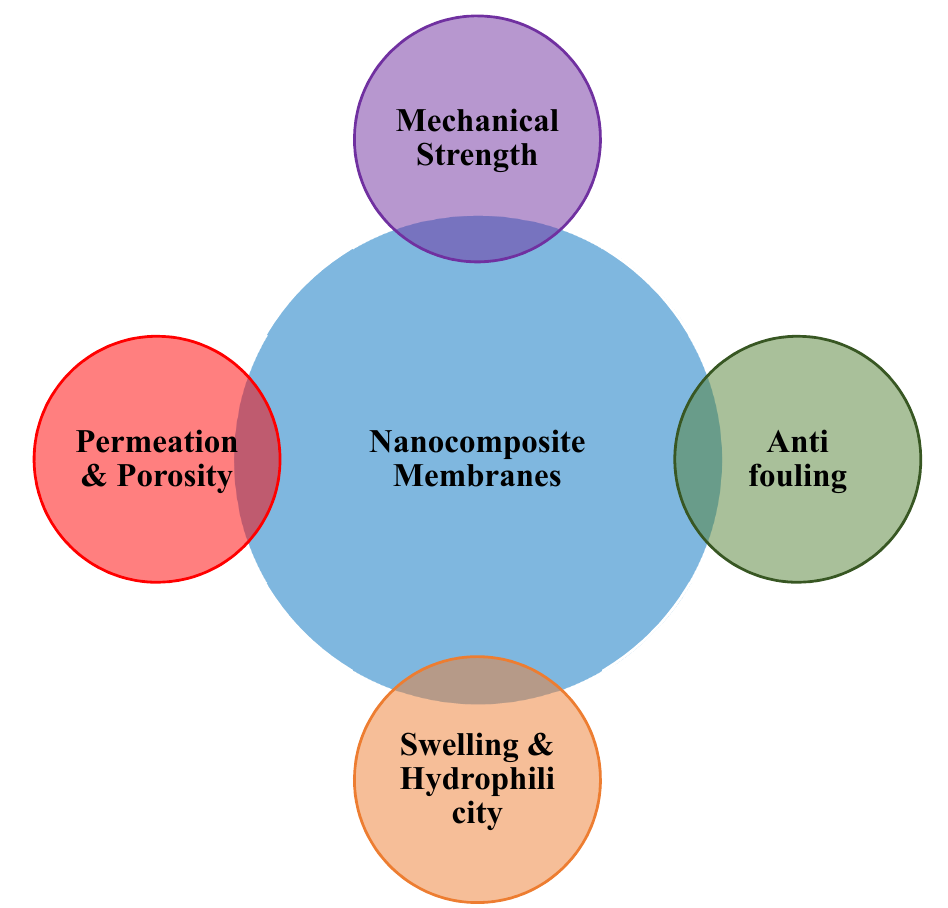
Figure 3. Important properties in the development of different nanocomposite membranes.